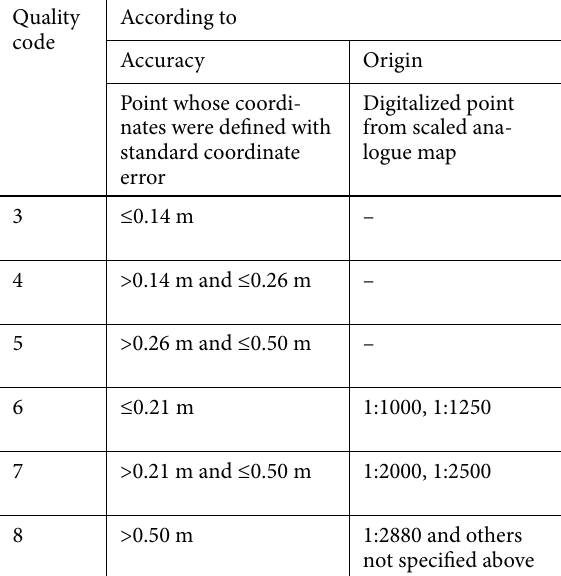
Table 1. Quality codes of detail points (Český… 2007) Quality